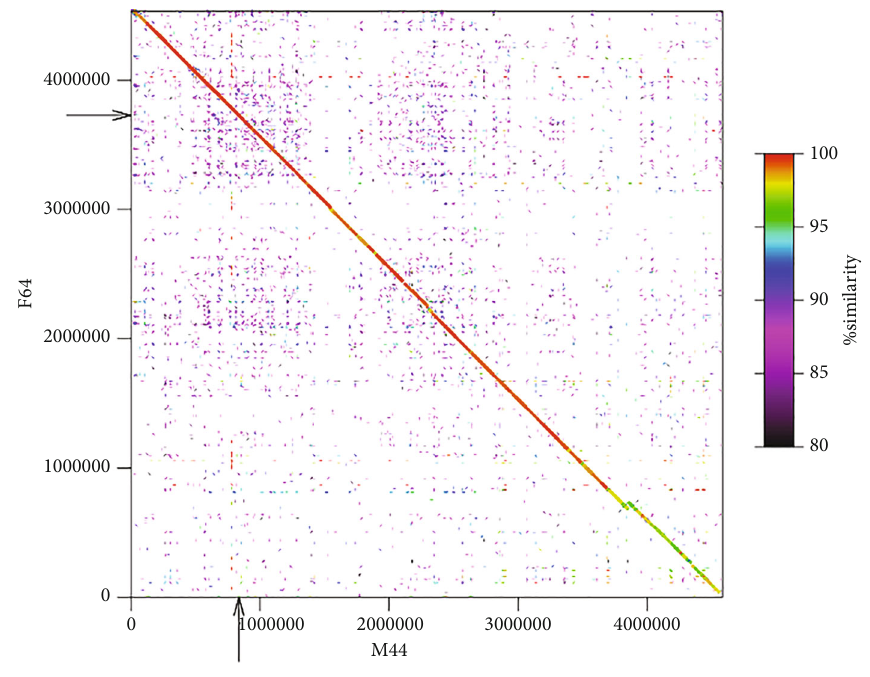
Figure 2: Sequence comparison between male sca ff old M44 and female sca ff old F64. The 6.5kb SLRs are indicated with arrows, respectively.